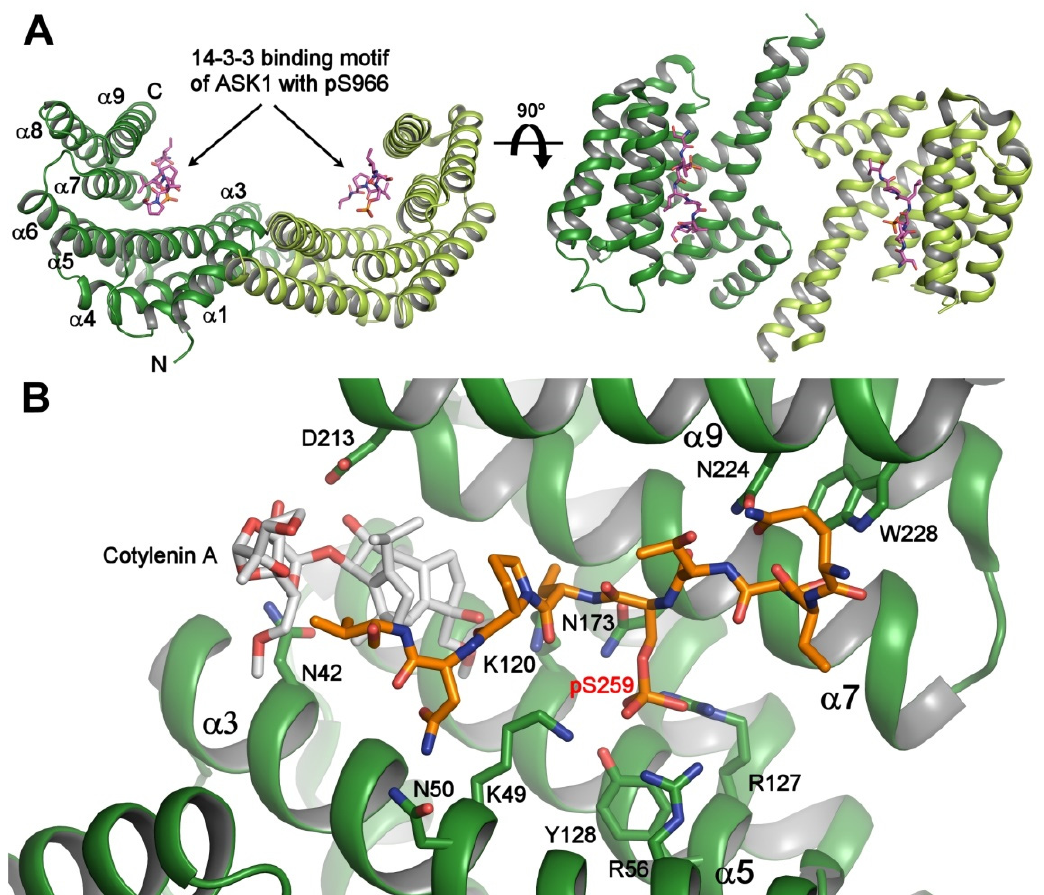
Figure 1. Crystal structure of the 14-3-3 protein with bound phosphopeptides. ( A ) The 14-3-3 binding motif of apoptosis signal-regulating kinase 1 (ASK1) (sequence RSIpS 966 LPVP) bound to human 14-3-3 ζ (PDB ID: 6EJL). The 14-3-3 protein molecule is a dimer with a two-fold symmetry,